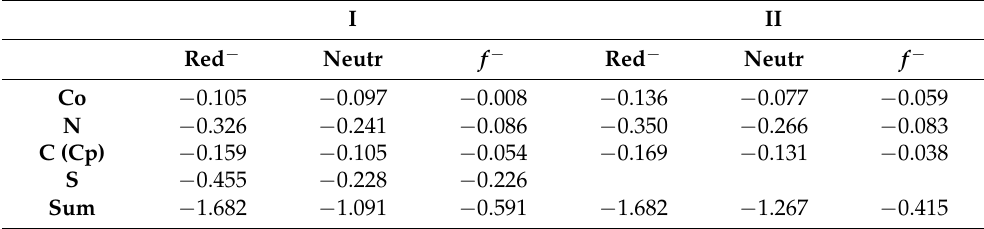
Table 4. ADCH charges for the core group atoms of the catalyst in the reduced form (Red • – ) and in the neutral species (Neutr)—both calculated on the optimized anion and the corresponding condensed Fukui function ( f − ). I